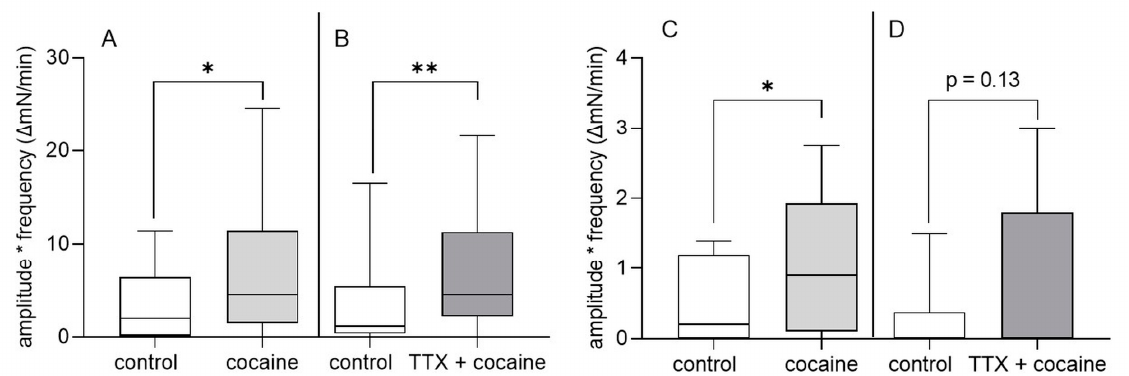
before the drug was applied (43.7 (8.2/78.1) ∆ mN vs. 59.1 (13.2/100.0) ∆ mN, paired t test, p = 0.01, n = four animals, eight MPPs).